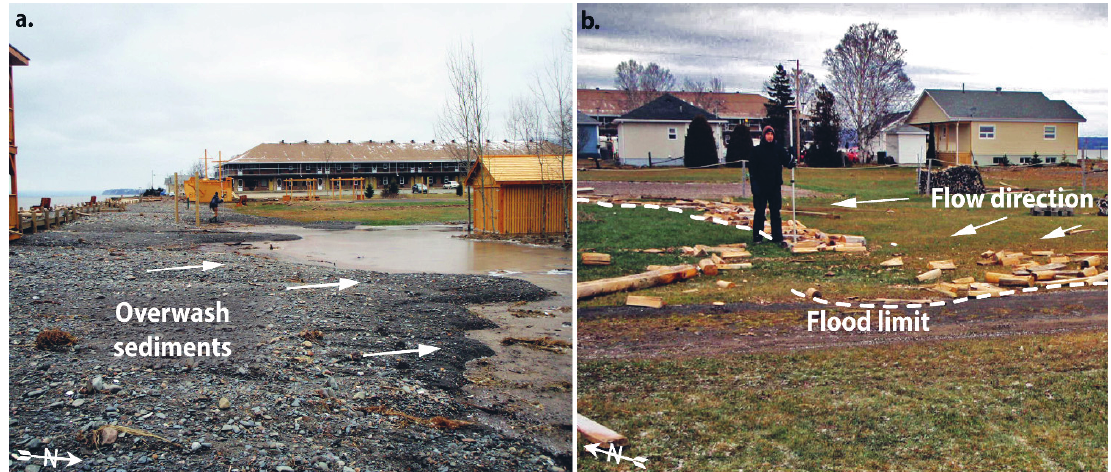
Figure 3. Field survey after the flood showing ( a ) flood generated overwash fan and ( b ) the debris line delineation. Limits were located using DGPS on the day following the storm event (Maria, 7 December 2010).